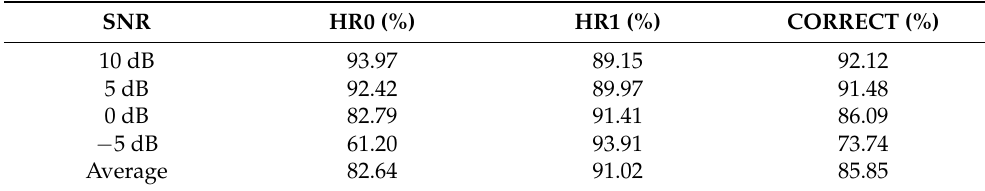
Table 1. Average evaluation parameters (HR0, HR1, CORRECT) over all 12 types of noises for each SNR levels ranging from − 5 to 10